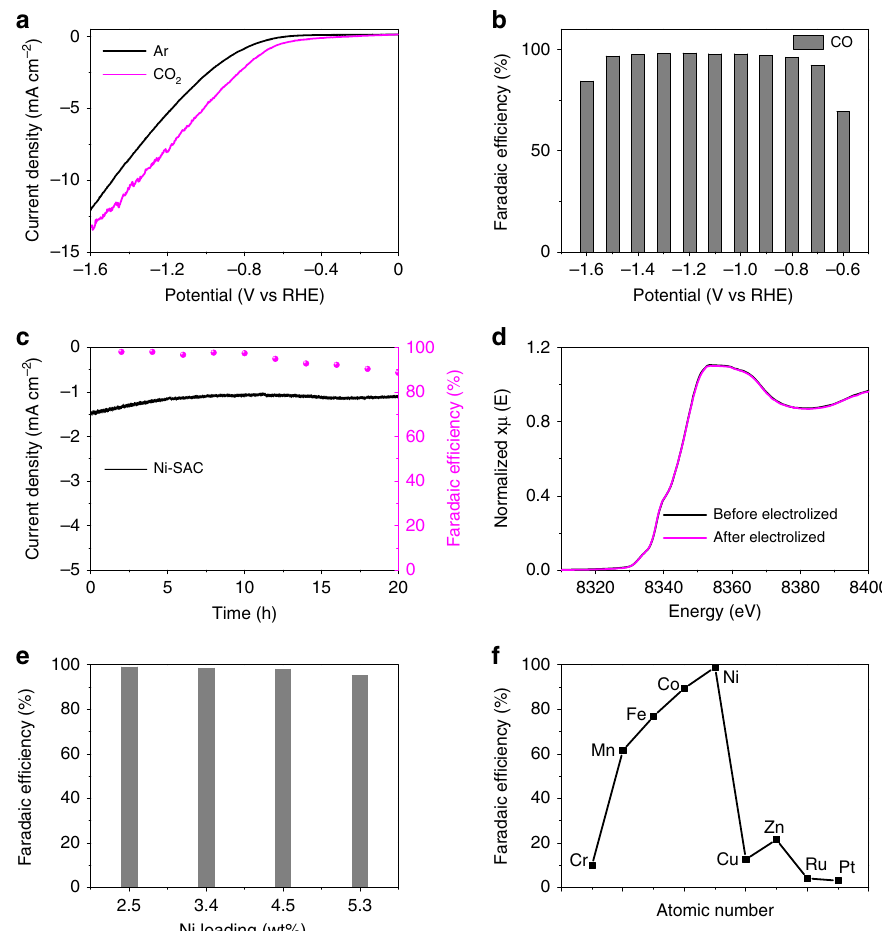
Fig. 6 CO 2 electrochemical reduction performance of metal single-atom catalysts. a Cathodic LSV scans for Ni-SAC-2.5 in Ar-saturated and CO 2 -saturated aqueous 0.1 M KHCO 3 solutions. b FE CO for Ni-SAC-2.5 at different potentials in a CO 2 -saturated aqueous 0.1 M KHCO 3 solution. c Stability test for Ni- SAC-2.5 at − 0.8 V vs RHE. d XANES spectra for Ni-SAC-2.5 before and after CO 2 RR tests. e FE CO for Ni-SAC-x at − 1.2 V vs RHE. f FE CO for M-SACs at − 1.2 V vs